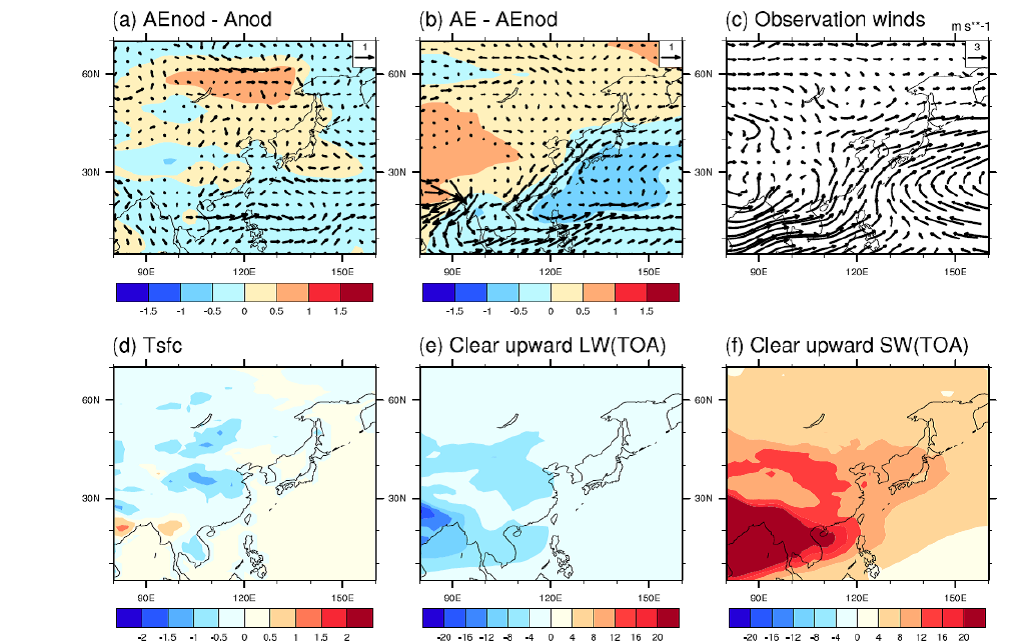
Figure 8. Changes in mean sea level pressure (hPa) and 850hPa winds (ms − 1 ) in JJA for (a) AEnod − Anod and (b) AE − AEnod. (c) Clima- tology of 850hPa winds for the period 1982–2005 using ERA Interim; (d to f) show differences between AE and AEnod in JJA: (d) surface temperature (K), (e) clear-sky upward longwave radiation (Wm − 2 ) and (f) clear-sky upward shortwave radiation (Wm − 2 ) at top of atmo- sphere, showing the impacts of the radiative effects from additional dust loading induced by the ES land cover.